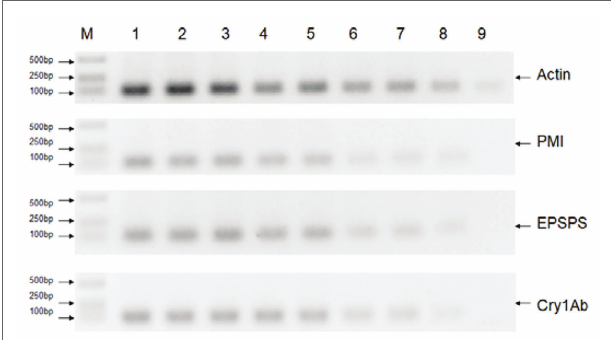
FIGURE 2 | Traditional PCR analysis of all samples. Lane M: DNA Marker; Lane 1: Leaf (GM); Lane 2: Stem (GM); Lane 3: Fiber (GM); Lane 4: Juice (GM); Lane 5: Filter mud (GM); Lane 6: Syrup (GM); Lane 7: Molasses (GM); Lane 8: Sugar (GM); Lane 9: Sugar